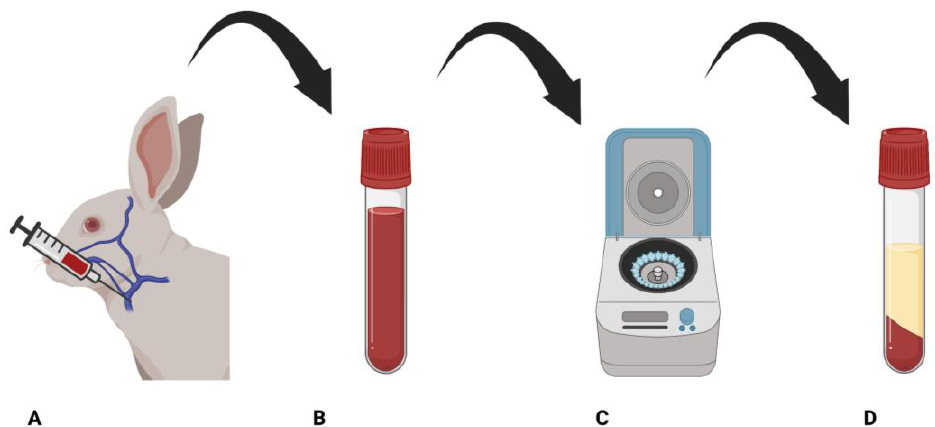
Figure 4. ( A ) The jugular vein puncture in the rabbit’s neck using a syringe with a needle ranging between 18–23G; ( B ) Blood placed in a tube/falcon (without additives); ( C ) The tube is then quickly placed in the centrifuge, following protocols for PRF production, rpm, time, and RCF; ( D ) PRF is produced after following the previous steps.